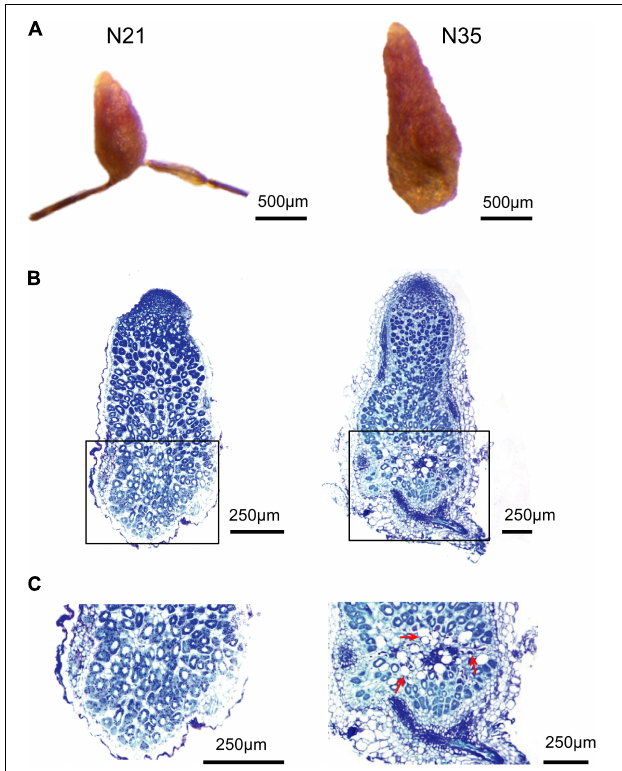
FIGURE 1 | Microscopic analysis of nodule senescence. (A) The appearance of N21 and N35. (B) Paraffin-embedded slides of N21 and N35 stained with toluidine blue. (C) Enlargement of the rectangle in B. N21, N35, nodules at 21 or 35 dpi. Bars = 500 µ m (A) and 250 µ m (B,C) . The arrows point to the aging